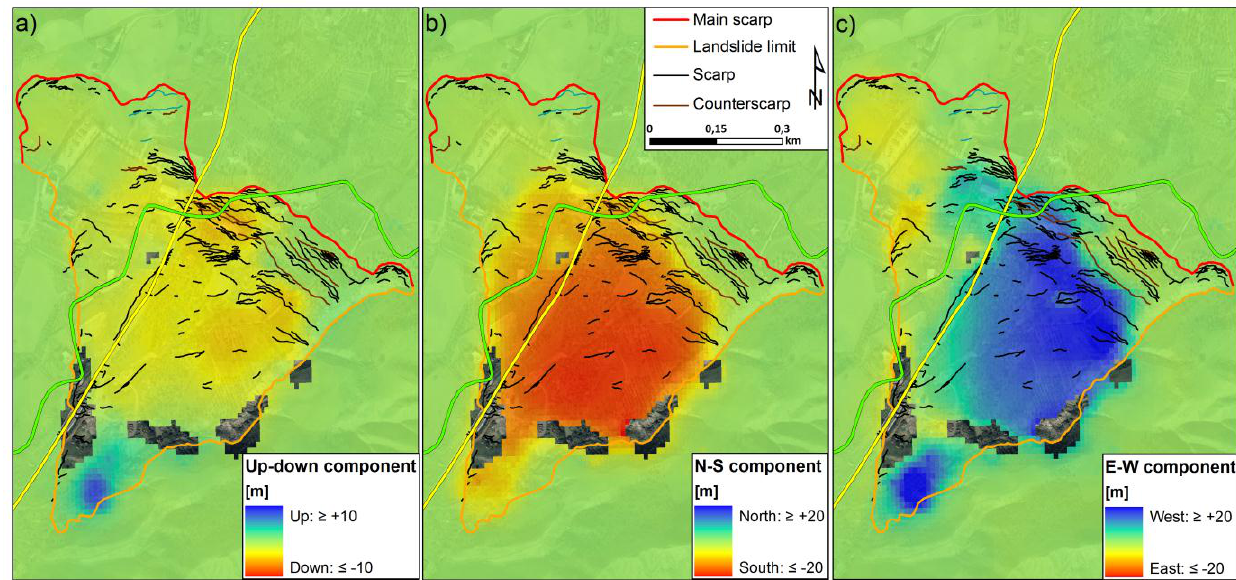
Figure 6. 3D deformation data related to the 3 December 2013 event in Montescaglioso. ( a ) Up-down, ( b ) North–South, and ( c ) East-West components of the deformation vector retrieved by Rapid Motion Tracking. Colored lines correspond to the main roads.